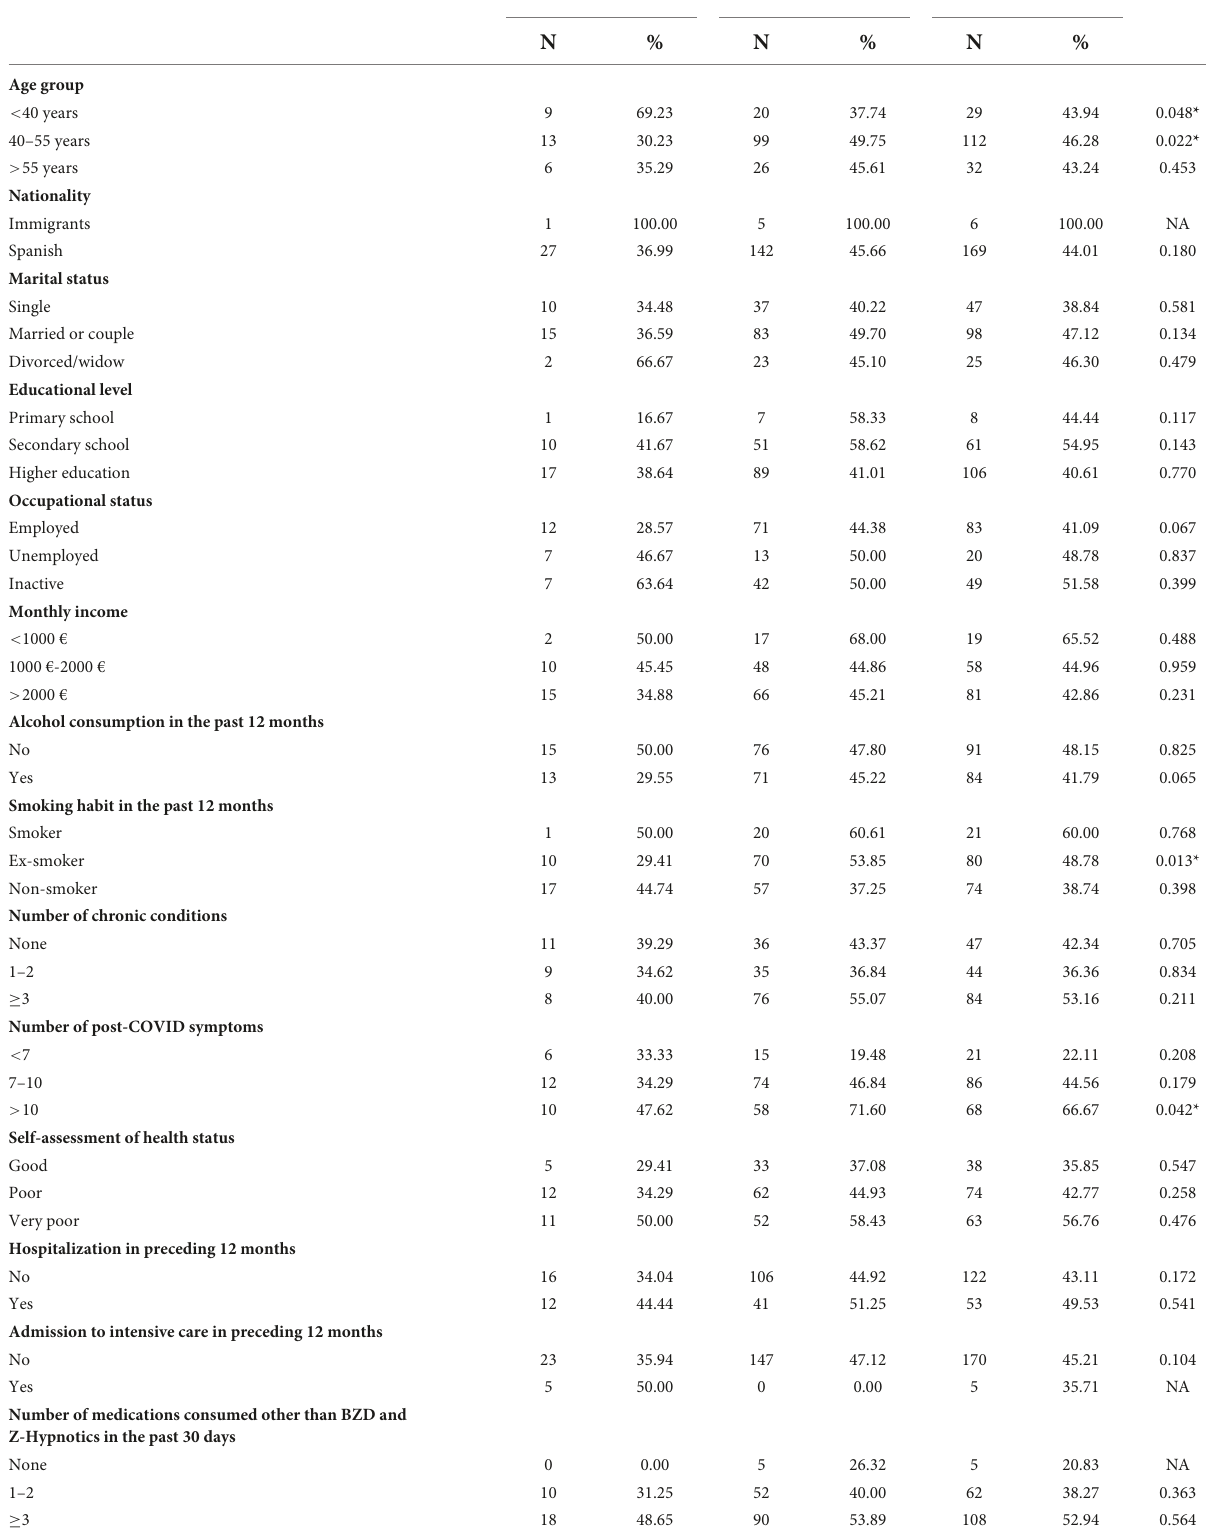
TABLE 2 Prevalence of BZD and Z-hypnotics consumption in patients with long COVID-19 according to sociodemographic, health profile and use of healthcare resources variables. Male ( N =